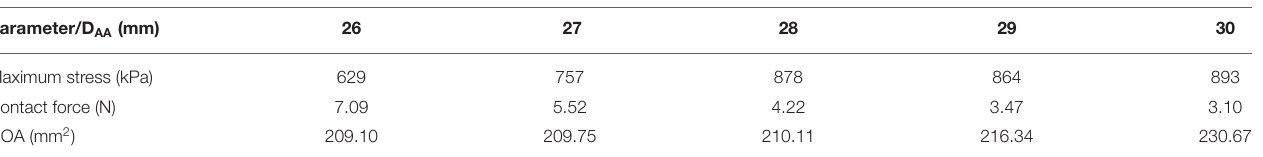
TABLE 2 | Parameter values of the model with a valve height of